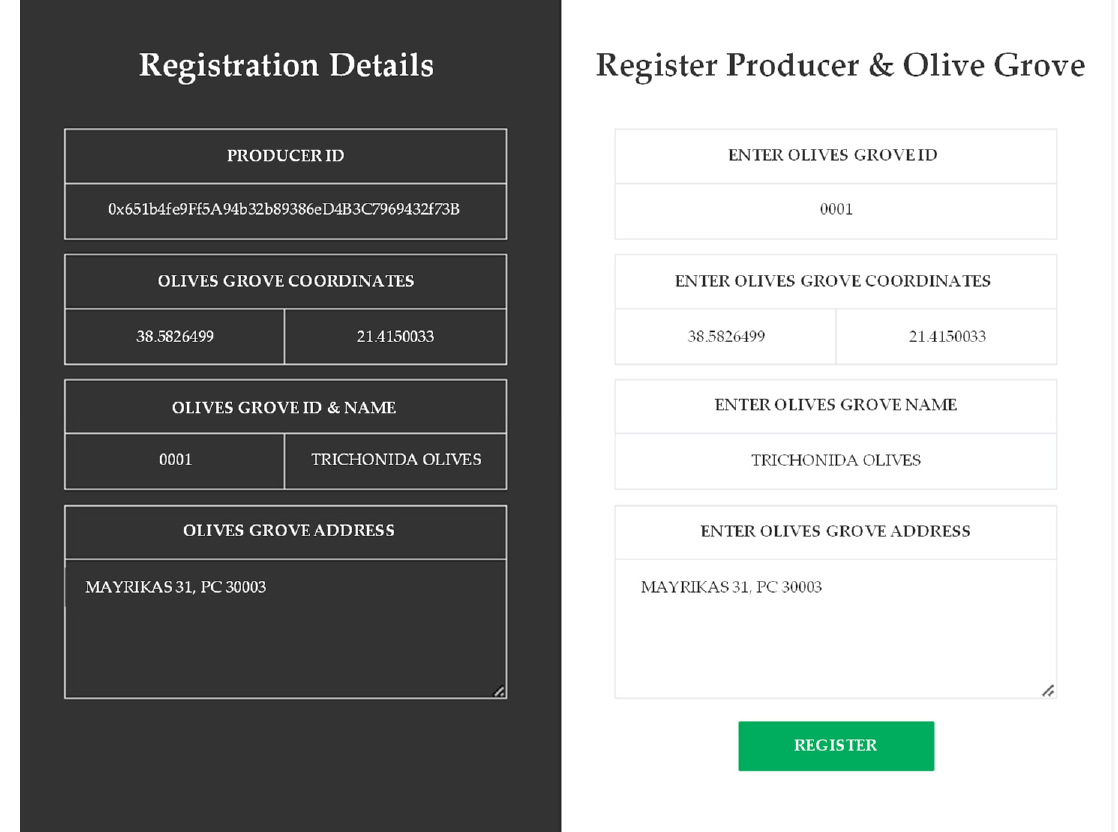
Figure 3. Registration of the Producer and the Olive Grove.